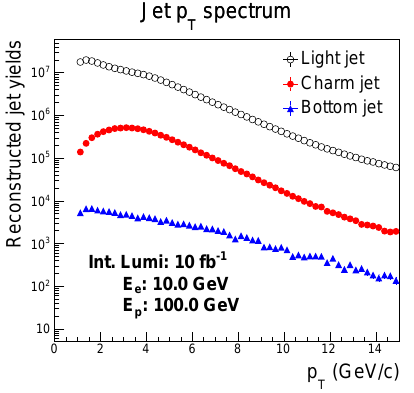
Figure 4: Reconstructed light, charm, and bottom jet transverse momentum (p ) de- T pendent yields in 10 GeV electron and 100 GeV proton collisions with the integrated luminosity of 10 f b − 1 . Reconstructed light flavor jet p spectrum is shown in open T black circles, reconstructed charm jet p spectrum is shown in red solid circles and T reconstructed bottom jet p spectrum is shown in blue solid T